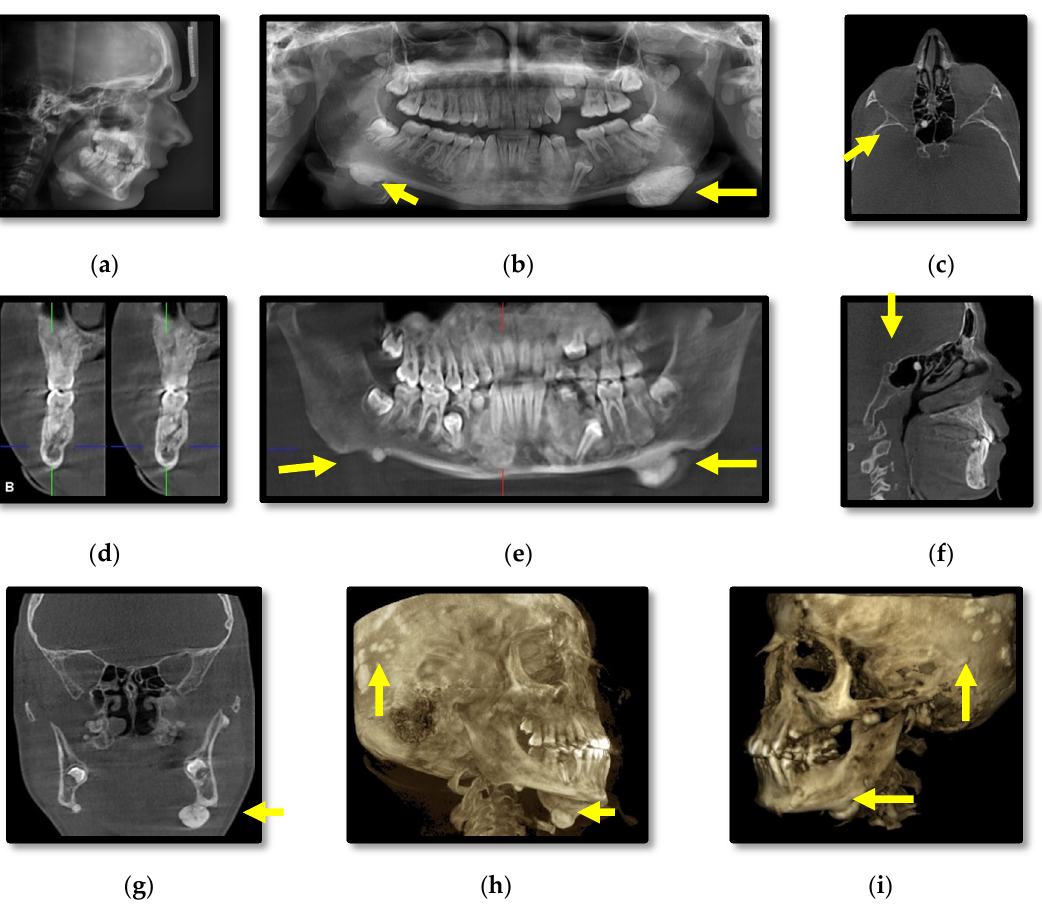
Figure 3. Patient III.2. Cephalometric ( a ) and panoramic ( b ) radiographs; CBCT axial ( c ), cross-section ( d ), panoramic ( e ), sagittal ( f ), coronal ( g ), 3D lateral-oblique ( h ) and 3D sagittal ( i ).